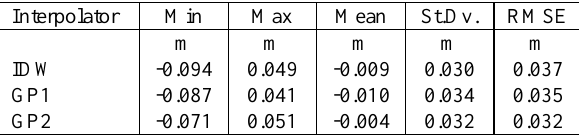
Table 4. Statistical values of the residuals obtained in 20 CPs in the case of GUMs based on 60